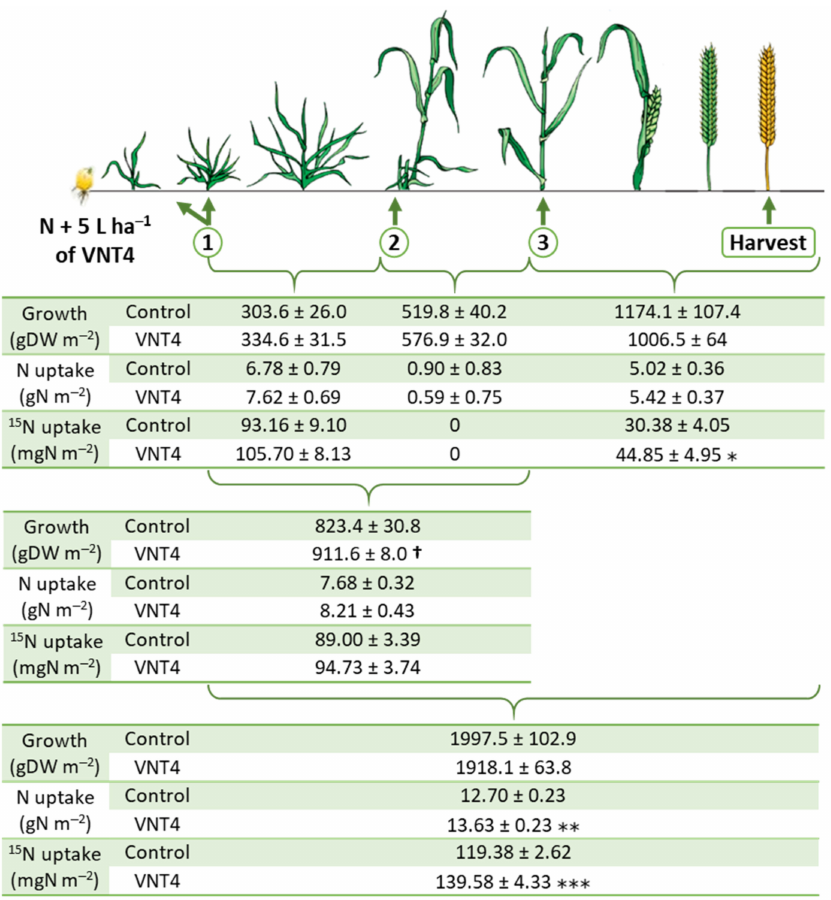
Figure 3. Influence of VNT4 on aerial biomass, N and 15 N accumulation in aerial parts between each N and VNT4 application at site 4 in 2020. Plant culture was carried out in France, Normandy. N was provided at the tillering (1), stem elongation (2) and flag leaf stages (3). 5 L ha − 1 of VNT4 formulation (see Table 1 for more details) were mixed with UAN before each N application, leading to a global application of 15 L ha − 1 . Stars denote significant differences between control and VNT4 according to a pairwise comparison (Fisher’s test: *; p < 0.05, **; p < 0.01, ***; p < 0.001, or Kruskal–Wallis test: †; p < 0.05, n =